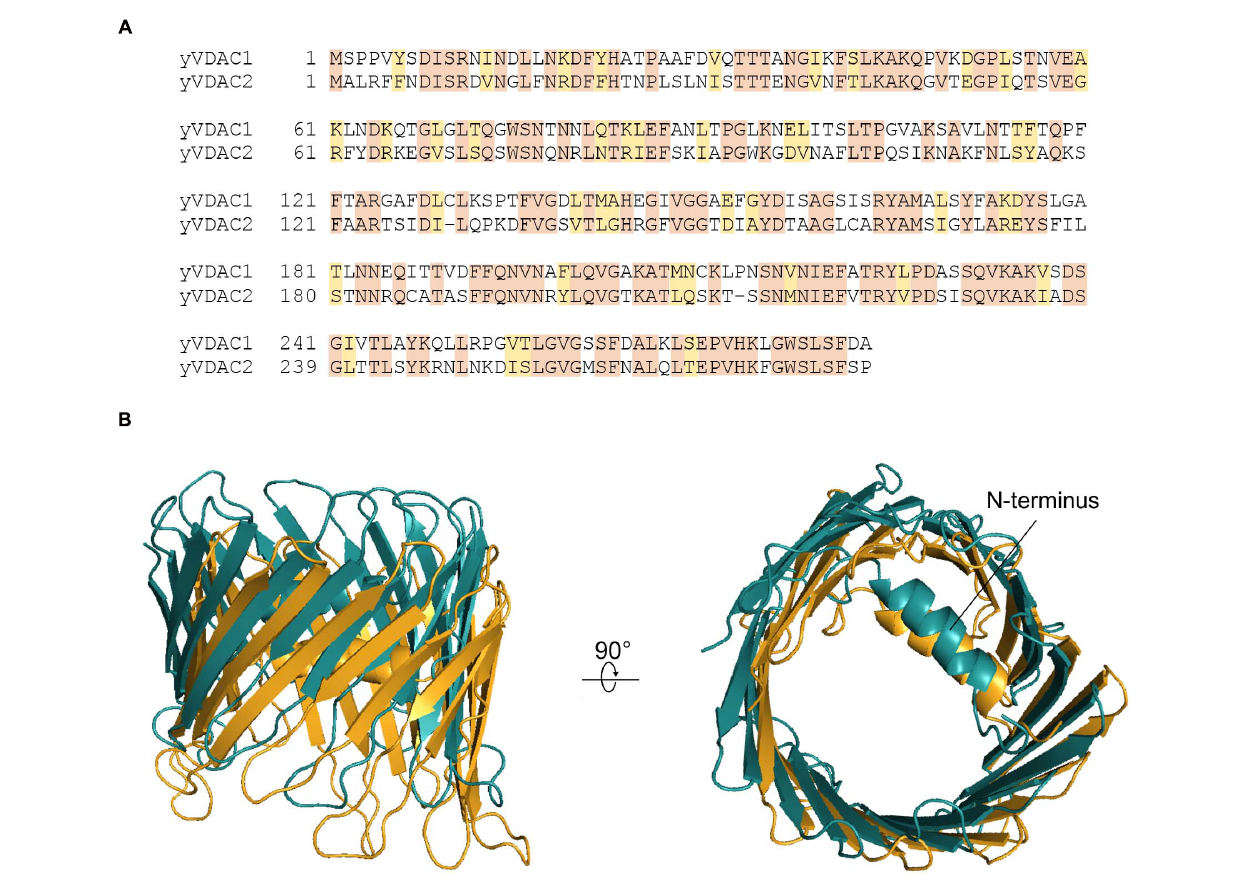
FIGURE 1 | Structural features of yeast voltage-dependent anion selective channel (VDAC) isoforms. (A) Multi-alignment analysis of the amino acid sequences of yVDAC1 and yVDAC2 (source: GeneBank). Colors highlight the conserved (orange) or similar (yellow) residues. (B) Lateral and top view of the superposition of yVDACs. The predicted structure of yVDAC1 (in brigthorange) and yVDAC2 (in teal) were obtained by homology modeling using MODELLER 9.24 software and the human VDAC1 structure (PDB ID: 2JK4) as template. Final figures were drawn using PyMol